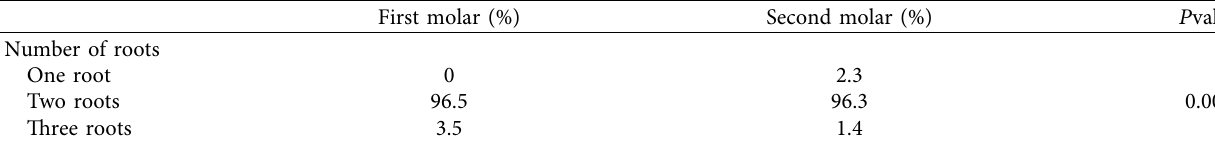
Figure 2: Axial CBCT sections for C-shaped canals. (a) Type C1 in tooth #47. (b) Type C2 in tooth #37. (c) Type C2 in tooth #47. Table 1: Frequency of the numbers of roots in permanent mandibular molars.